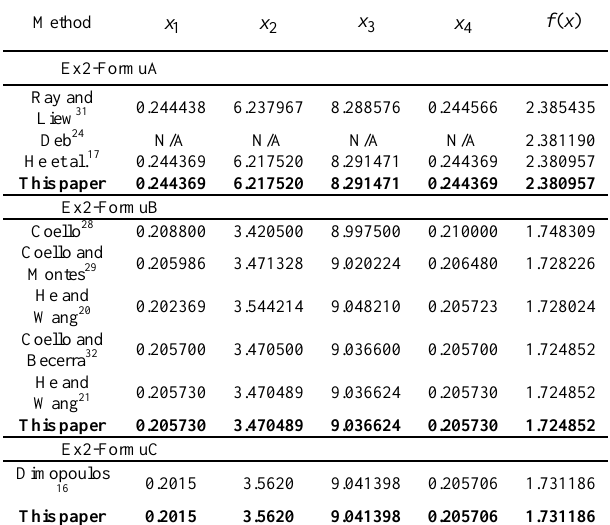
Table 6. Comparison of the best solution for the welded beam design problem.